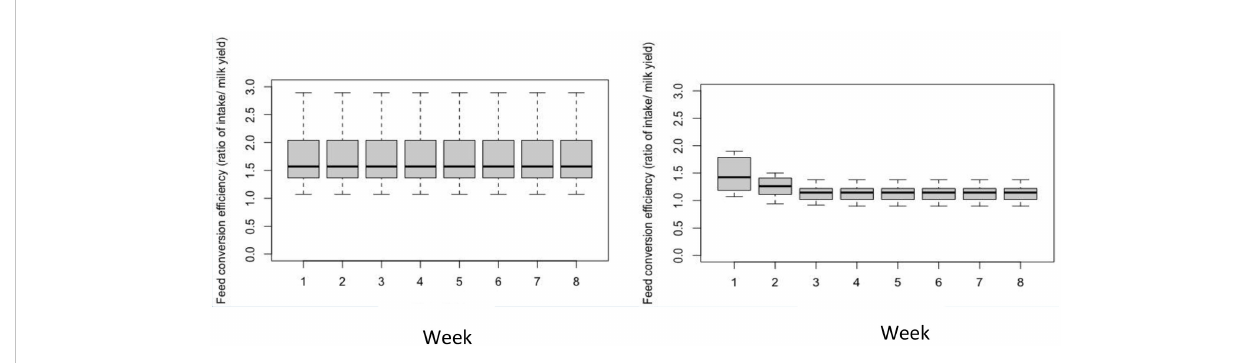
FIGURE 6 Comparison of effects of traditional feeding practice (left) and intervention diets (right) on feed conversion ef fi ciency (ratio of intake/milk yield).